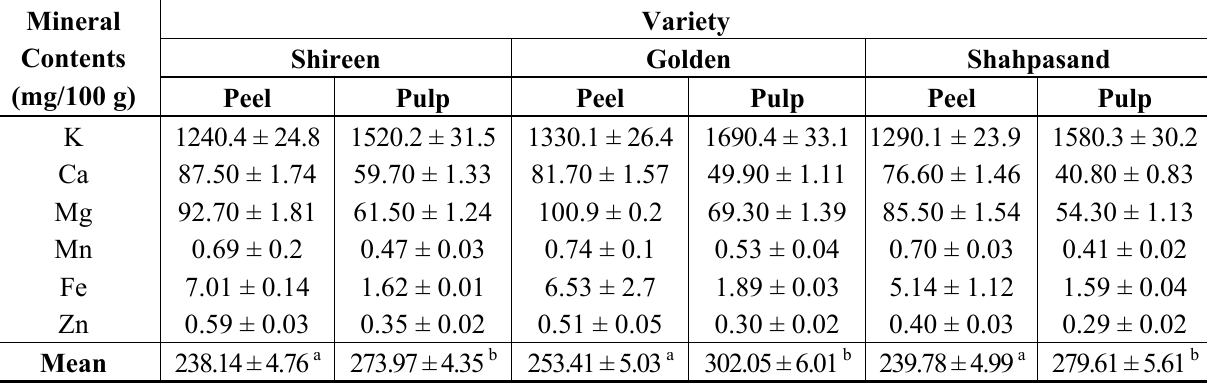
Table 3. Mineral contents in peel and pulp of different varieties of peach ( Prunus persica L.) fruit.